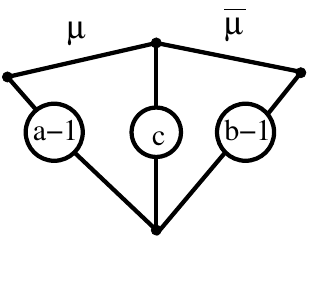
Figure 9 . B ( a; b ; c ).